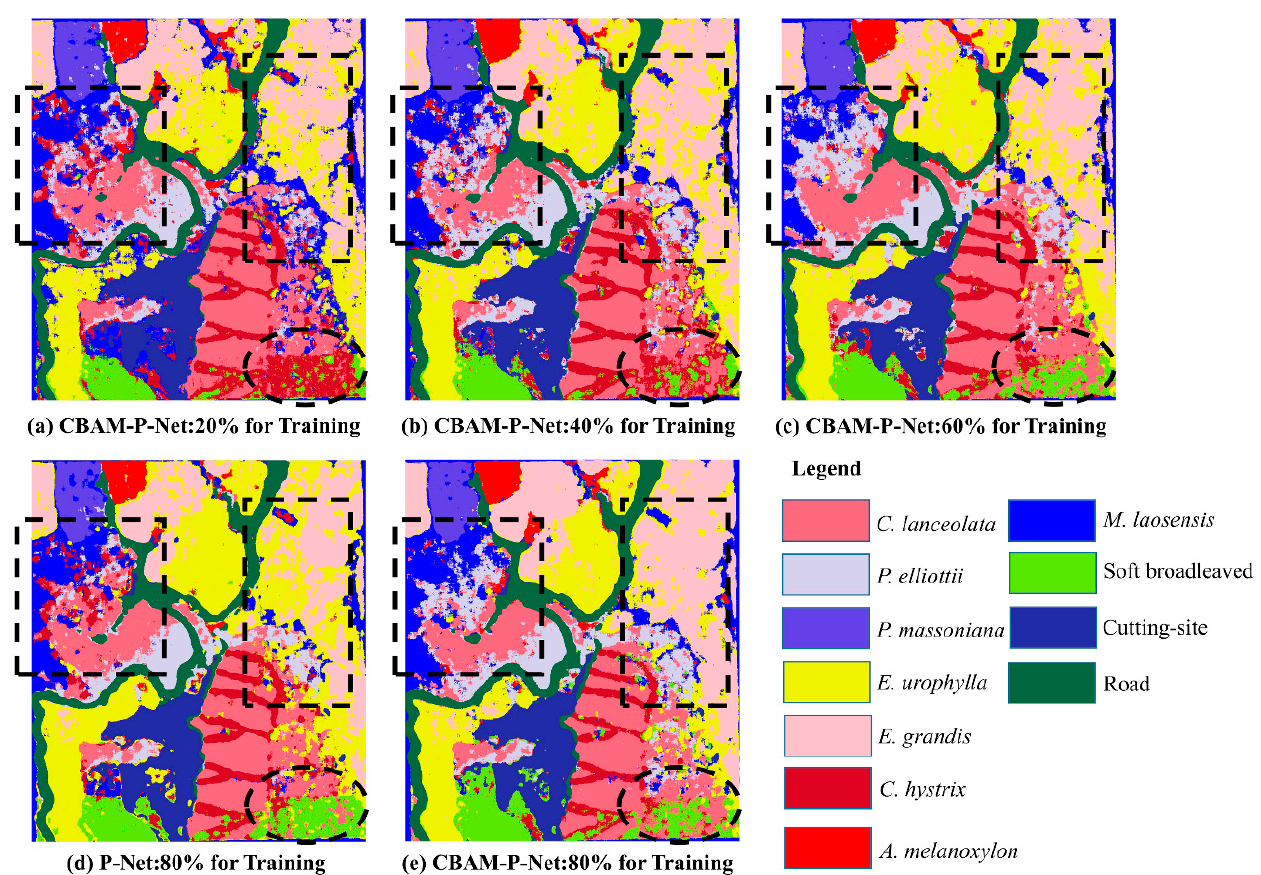
Figure 11. Classification maps of CBAM-P-Net and